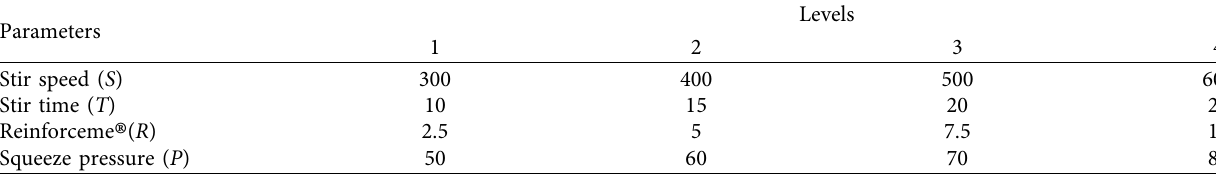
Table 3: Casting parameters with different levels.